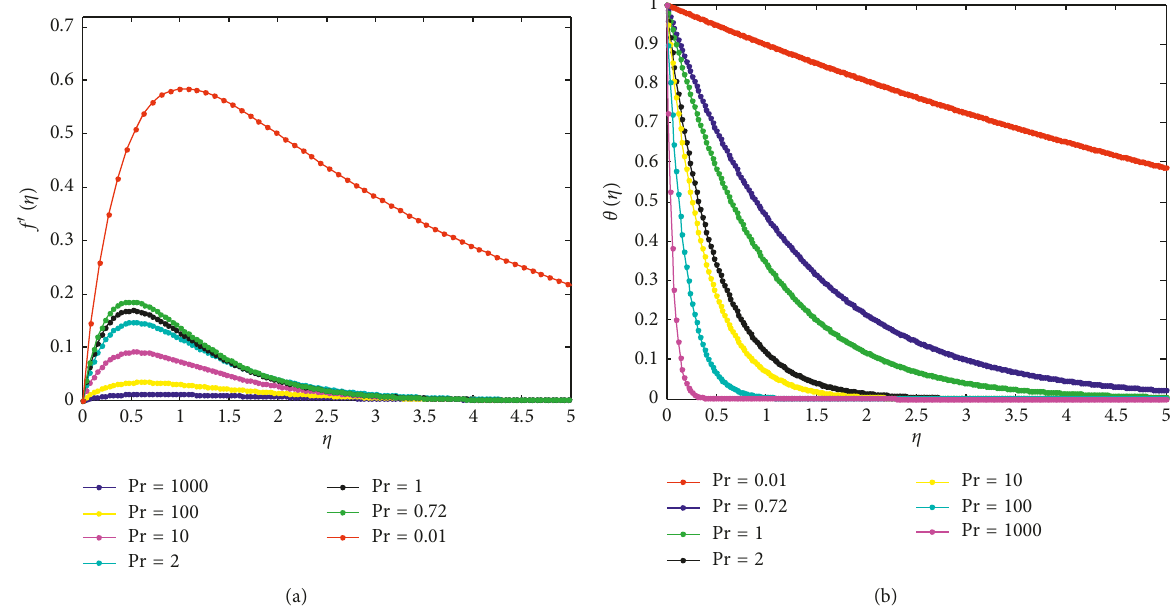
Figure 12: (a) Effects of Prandtl number on the velocity profile for brick-shaped nanoparticle. (b) Effects of Prandtl number on the temperature profile for brick-shaped nanoparticle.